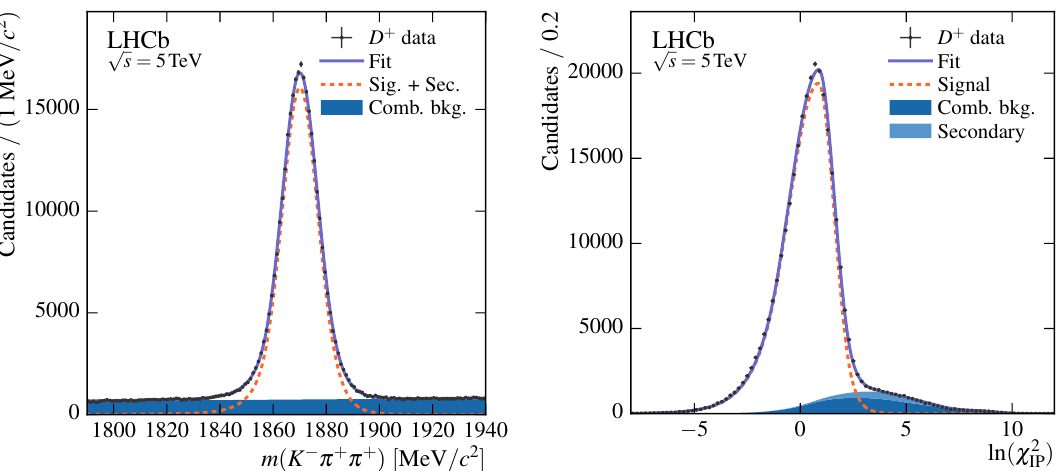
Figure 2. Distributions for selected D + (cid:0) (cid:1) and (right) ln (cid:31) 2 for a mass window of IP